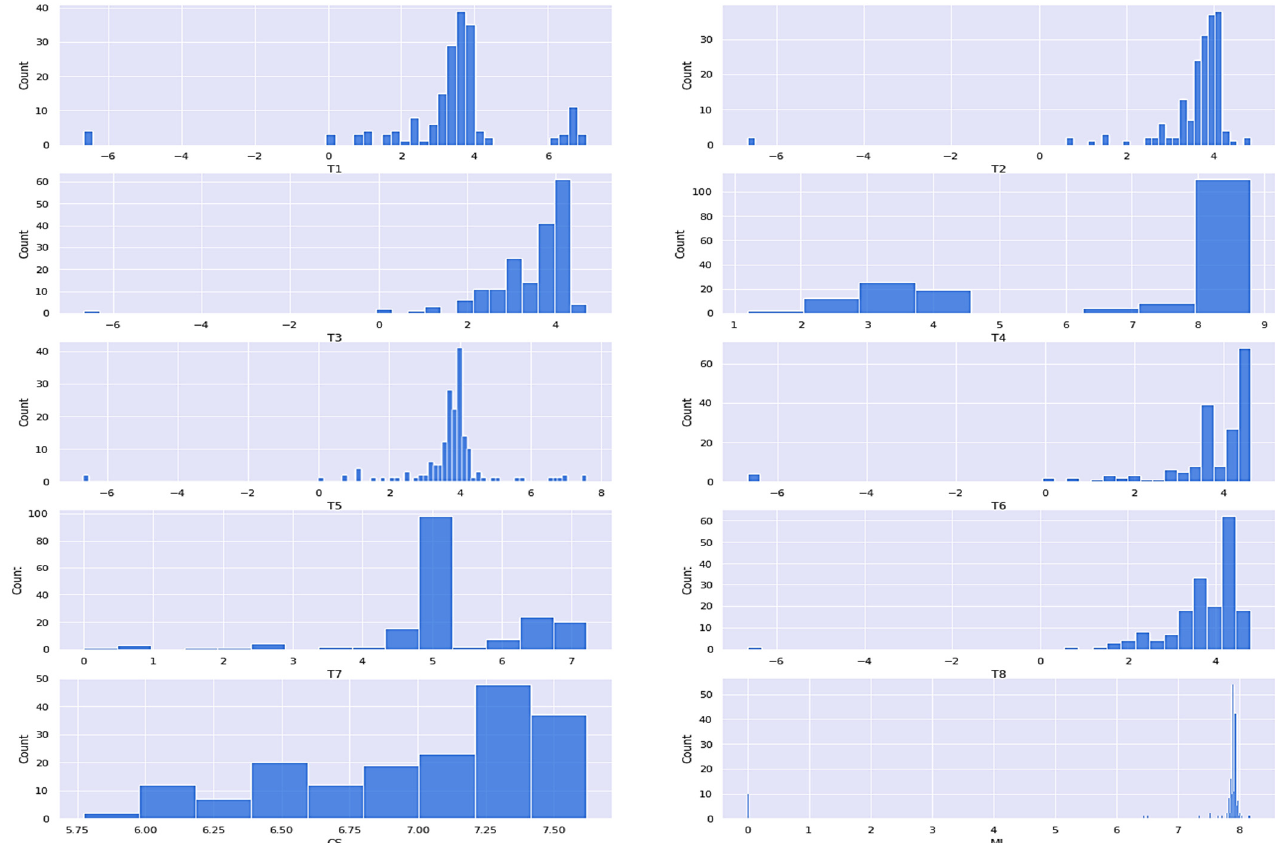
Figure 9. Histogram plots of the frequency distribution of all the variables (thermocouple tempera- tures (T1, T2 … T8), casting speed (CS), and mold level (ML).